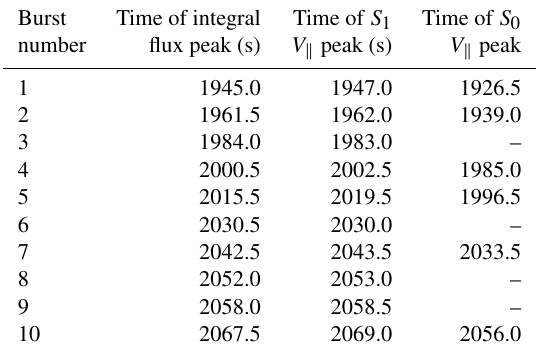
Table 1. Times of peak integral energy flux and plasma bulk parallel velocities at S 1 and S 0 for the main bursts of proton precipitation. In the last column, an en dash indicates whenever a given precipitation burst observed at S 1 could not be traced back to S 0